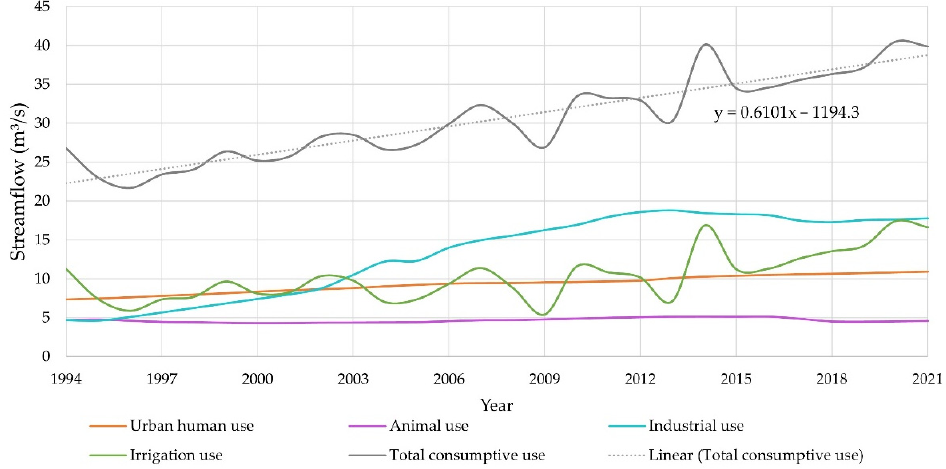
Figure 5. Average water use at Marechal Mascarenhas de Moraes, Furnas and Marimbondo hydroelectric plants (accumulation).